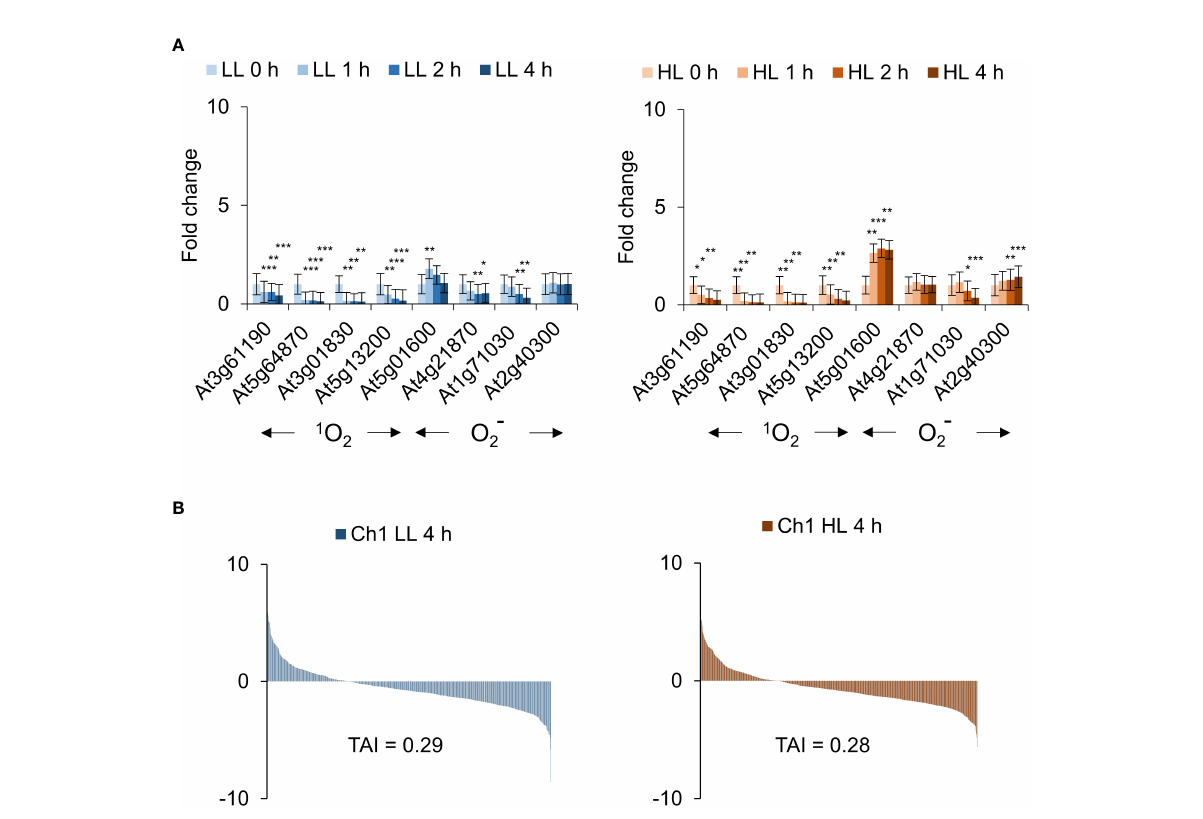
FIGURE 7 Ch1 seedlings do not present cytosolic 1 O Ch1 seedlings were exposed to low 2 signatures under low and high light treatment. (A) Arabidopsis light (30 µE m -2 s -1 ) or high light (1000 µE m -2 s -1 ) for 0, 1, 2, 4 h). RNA was extracted and processed as described in the Materials and Methods for qRT-PCR analysis. The means and SE of three replicates is shown. Student ’ s t-test was performed against their respective controls for signi fi cance (* - P<0.05; ** - P<0.01; *** - P<0.001). (B) Translational Attenuation Index analysis of Ch1 induced transcripts under low light